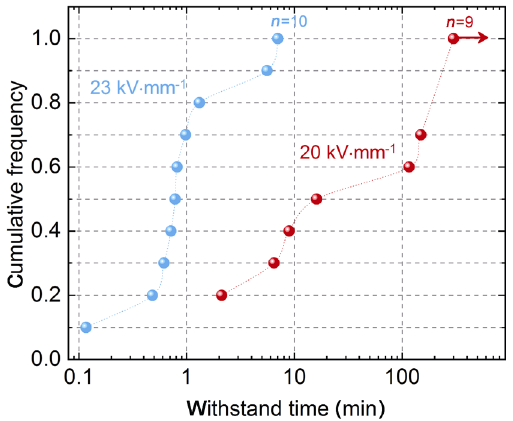
Fig. 8 Cumulative frequencies of withstand time of 620 µm Al 2 O 3 tested under different AC voltage gradients.